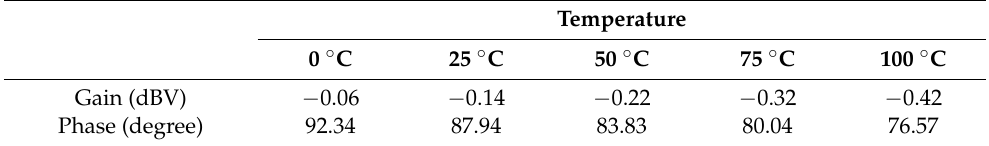
Table 5. Gain and phase values of the proposed VM AP filter at f p for different